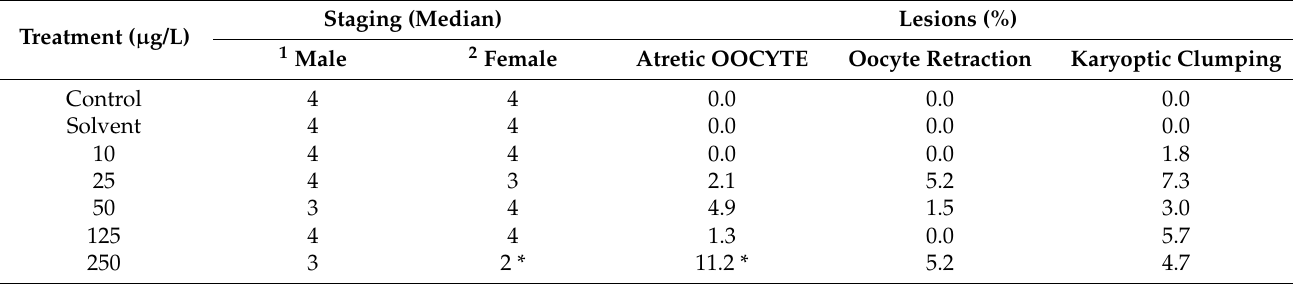
Table 3. Gonadal staging and ovarian lesions (n = 3) in Javanese medaka at 21 days post-exposure to 3,4-DCA.